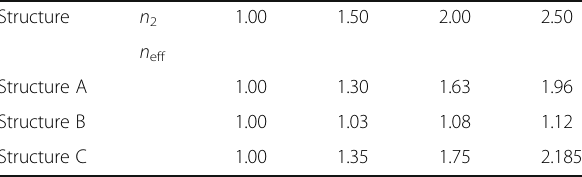
Table 1 n eff for different structures and with varying